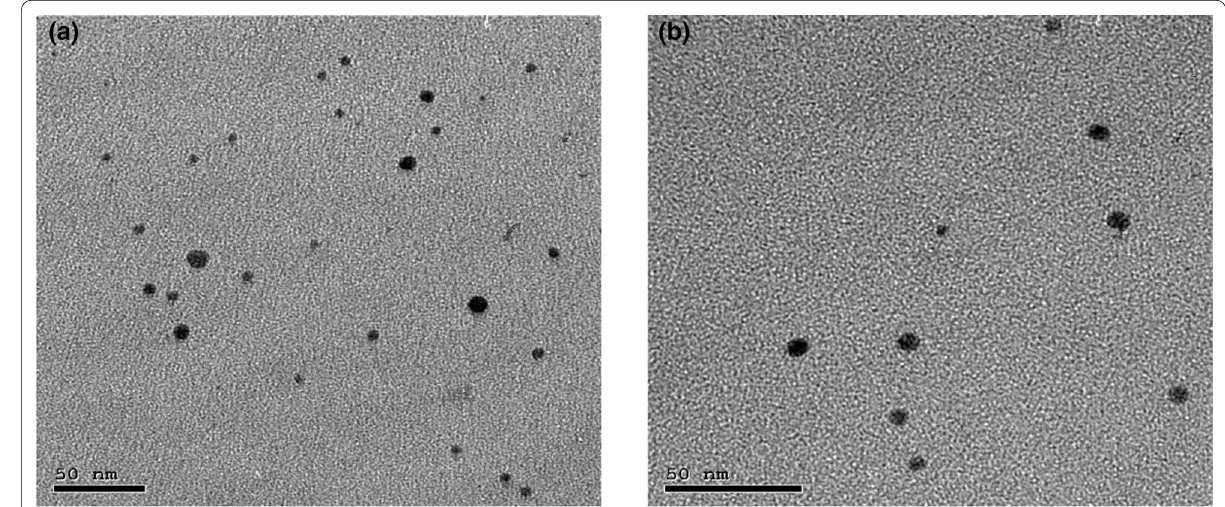
Fig. 1 a and b Image of silver nanoparticles AgNps by transmission electron microscope